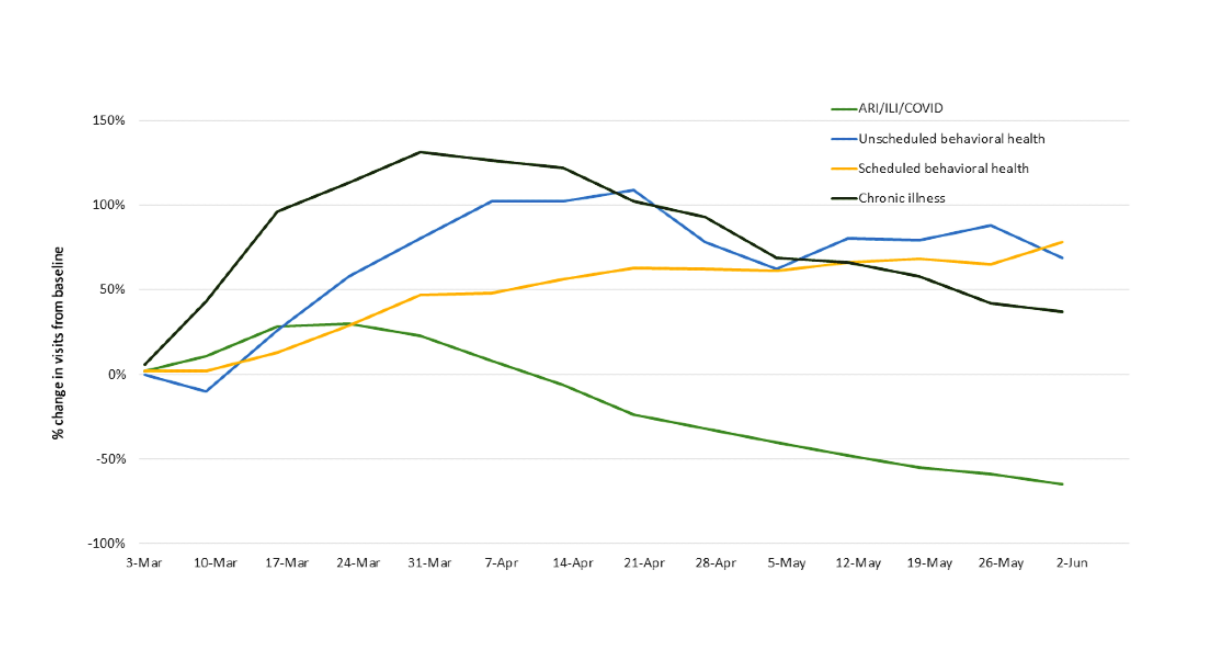
Figure 2. Percentage change in the total volume of virtual visits by type of visit from the baseline week in 2020. ARI: acute respiratory infection, ILI: influenza-like